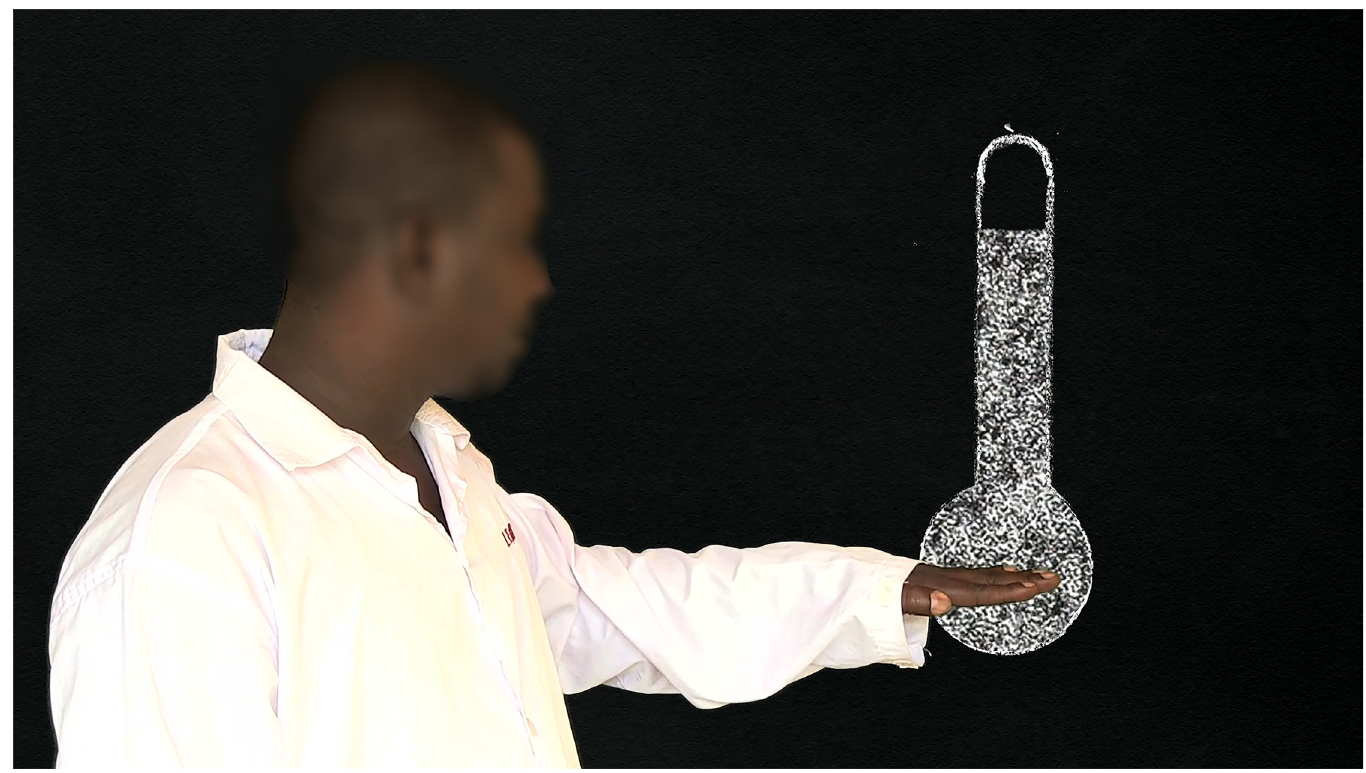
Fig 4. Interaction between the narrator and an infographic